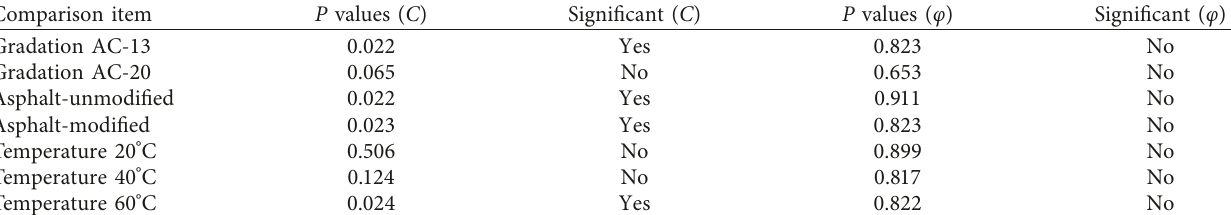
Table 2: Summary of P values of two methods.